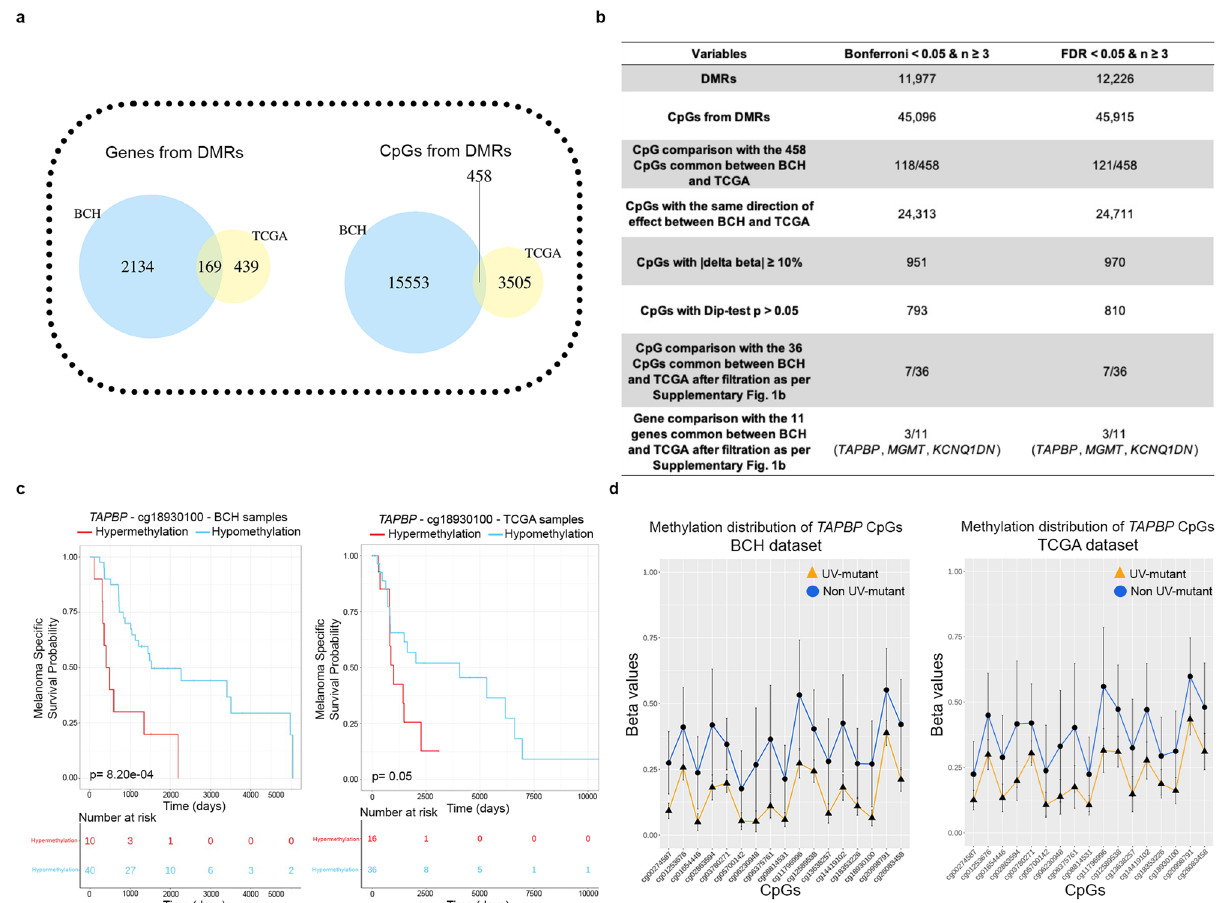
Fig. 4 UV-related DNA methylome-wide alterations common between BCH and TCGA are prognostic for survival in cutaneous melanoma patients. a Venn diagrams showing that DMR-derived 169 genes or 458 CpGs are common between BCH and TCGA, based on the crude model. b DMR fi xed effects inverse variance-weighted meta-analysis of BCH and TCGA, and comparison with the cohort-speci fi c analysis. c Kaplan – Meier survival of melanoma patients in relation to methylation levels of cg18930100 ( TAPBP ) measured in the target tumors derived from BCH and TCGA. Patients were categorized into low- and high-methylation groups depending on whether the methylation value of a given CpG is lower or higher, respectively, than the mean methylation across the samples pro fi led for that CpG. P values were derived by two-sided log-rank test. d DNA methylation pro fi les of cg18930100 ( TAPBP ) that is associated with melanoma-speci fi c survival, showing differential methylation between UV-mutant ( n = 40 and 41 in BCH and TCGA, respectively) and non UV-mutant patients ( n = 10 and 11 in BCH and TCGA, respectively). Data were expressed as the average values of each group (UV- mutant and non UV-mutant) for each single CpG with error bars indicating the 95% con fi dence interval (Fig. 2a) observed in UV-mutant relative to non UV-mutant patients. Notably, TAPBP differential methylation is robustly signi fi cant in both the cohort-speci fi c and meta-analyses of the BCH and TCGA cohorts (Fig. 4b and Supplementary Data 7, 8, 19, 20).